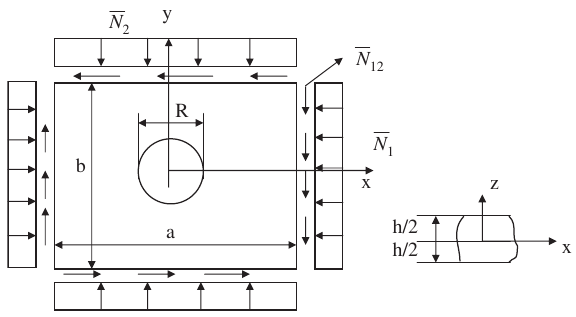
Figure 1 Notch geometry and loading (compressive)